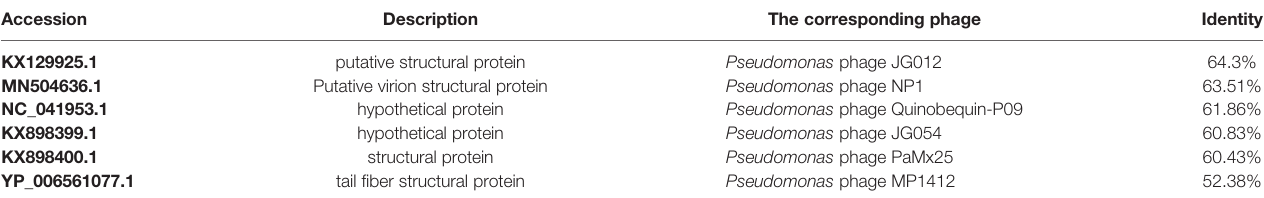
TABLE 3 | The sequence identity of the PAJD-1 ORF48 with other Pseudomonas